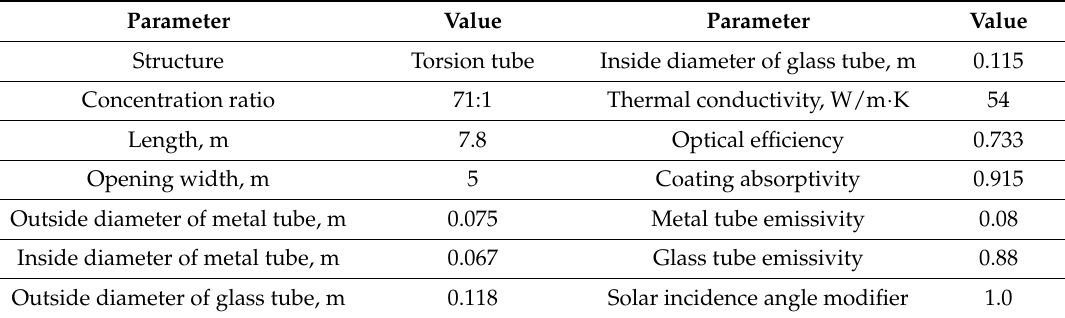
Table 1. Design parameters of the parabolic trough